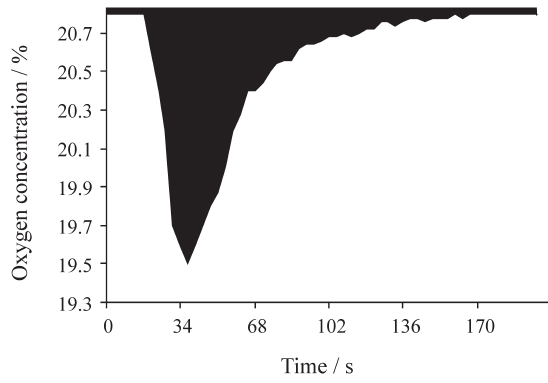
Figure 1 - Variation in O 2 concentration with